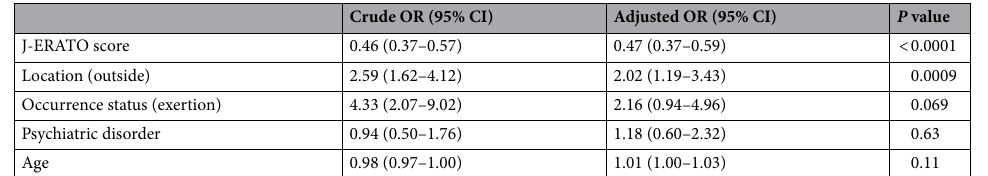
Table 3. Association of survival at hospital discharge with the J-ERATO score among all study subjects. Logistic regression models were used with adjustment for J-ERATO score, event location, circumstances of the occurrence, medical history of psychiatric disorder, and age. OR, odds ratio; CI, confidence